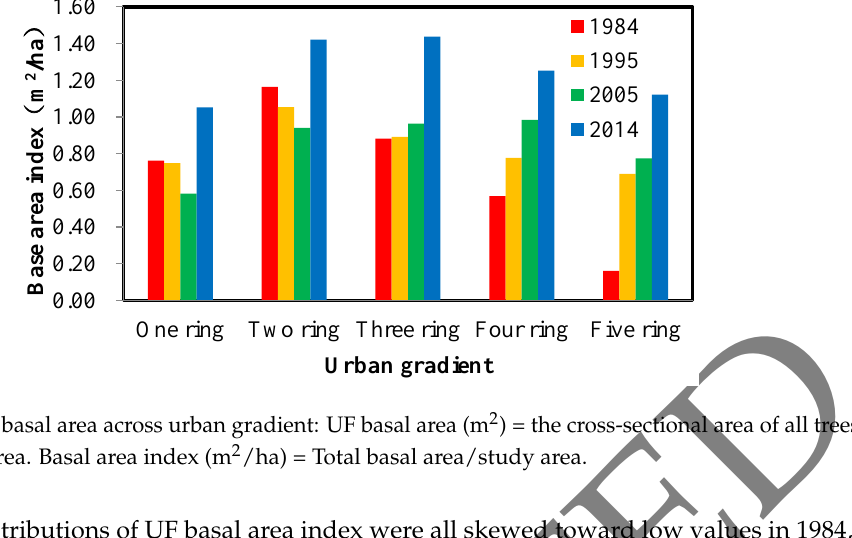
Figure 10. UF basal area across urban gradient: UF basal area (m 2 ) = the cross-sectional area of all trees in the study area. Basal area index (m 2 /ha) = Total basal area/study area.